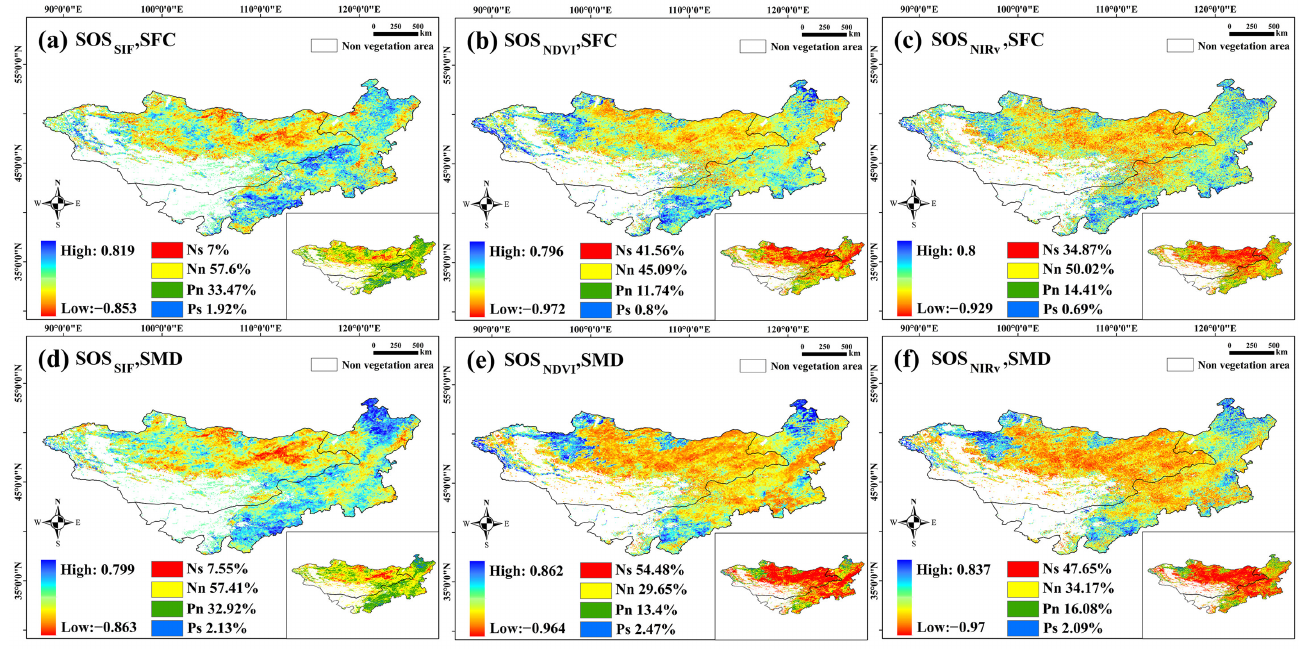
Figure 8. Spatial distribution of the correlations between winter snow-related climatic factors (SFC, SMD) and the three types of phenological parameters. Note: Ns: significant ( p < 0.05) negative correlation; Nn: nonsignificant ( p > 0.05) negative correlation; Pn: nonsignificant ( p > 0.05) positive correlation; Ps: significant ( p < 0.05) positive correlation. The same applies below.